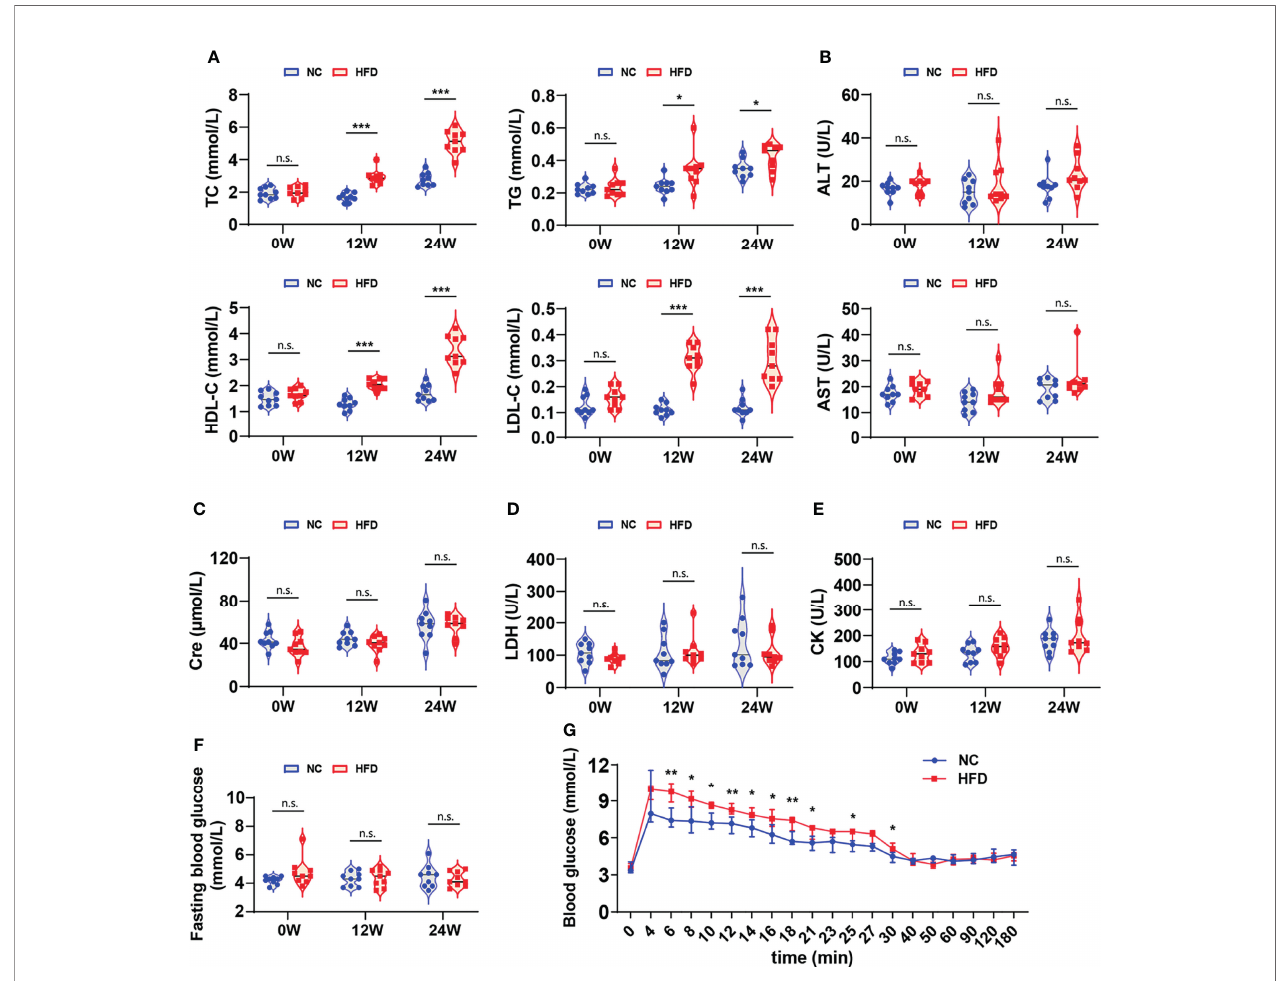
FIGURE 3 | Differences in serum biochemistry and glucose tolerance between HFD-induced metabolic disorder and NC dogs. (A – F) The levels of serum biochemical markers re fl ected the blood lipids, hepatorenal and cardiac function of dogs. Fasting blood glucose was measured in dogs that fasted overnight. n = 9 per group. Data are expressed in the form of violin plot. n.s. represents not statistically signi fi cant. Signi fi cance levels * P <0.05, *** P <0.001. (G) In the modi fi ed intravenous glucose tolerance test, the blood glucose level of the HFD group was dramatically higher than that of the NC group during most of the fi rst 30 minutes, indicating the presence of insulin resistance. n = 6 in NC group, and n = 8 in HFD group. Data are expressed as the median with interquartile range. Signi fi cance levels * P <0.05, ** P